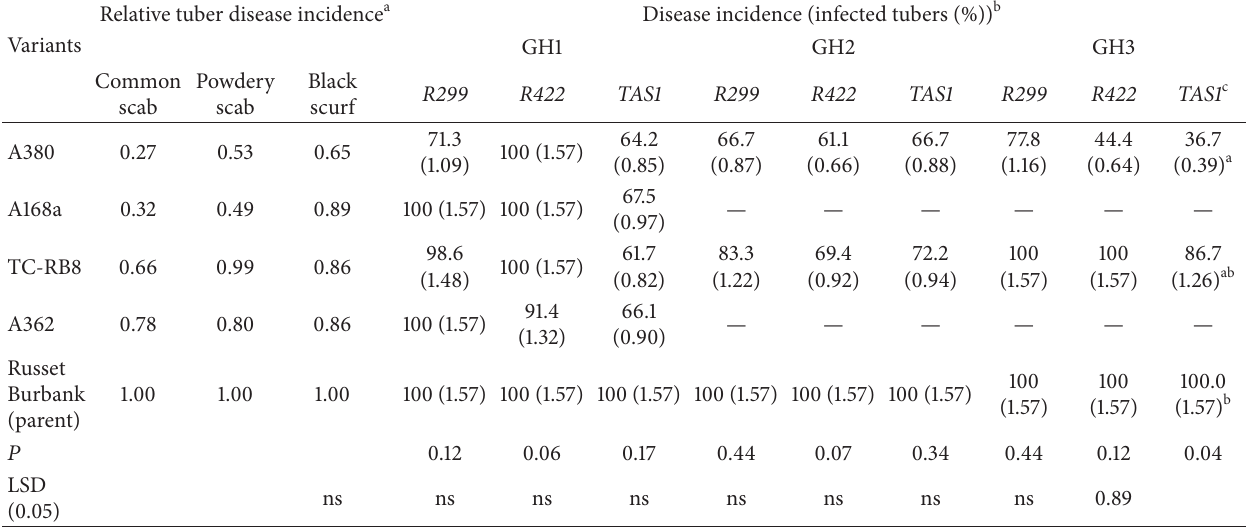
Table 2: Incidence of black scurf in selected potato cv. Russet Burbank variants in glasshouse (GH1—2010; GH2 and GH3—2011) trials. Rhizoctonia solani AG3 isolates R299, R422 , and TAS1 were tested separately in each trial. Relative tuber disease incidence a Variants